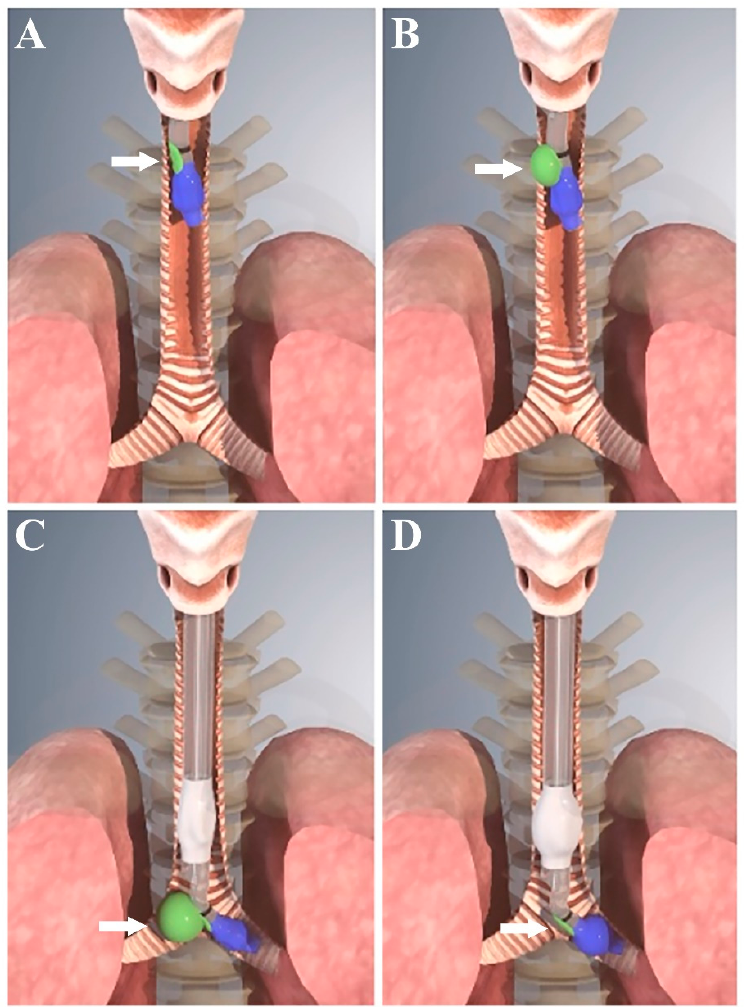
Figure 2. Schematic illustration showing the use of ANKOR double-lumen endobronchial tube (DLT). ( A ) The carinal cuff (green color, indicated by the white arrows) of the tube passed beyond the vocal cord, and the ANKOR DLT was turned to the left; ( B ) The carinal cuff was inflated with 5 to 7 mL of air; ( C ) The ANKOR DLT was advanced until the inflated carinal cuff is functionally anchored at the keel-shaped carinal ridge; and ( D ) After the deflation of the carinal cuff, the tracheal cuff (white color) and the bronchial cuff (blue color) of the tube were inflated with air.